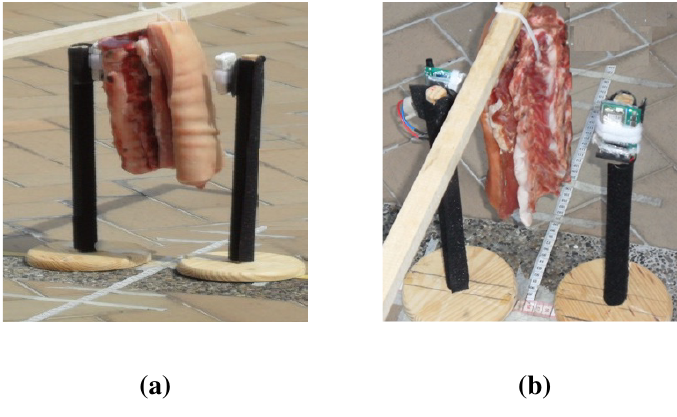
Figure 3. NLOS due to four-layered porcine tissue in outdoor environment. ( a ) Shimmer nodes; ( b ) Samsi nodes.